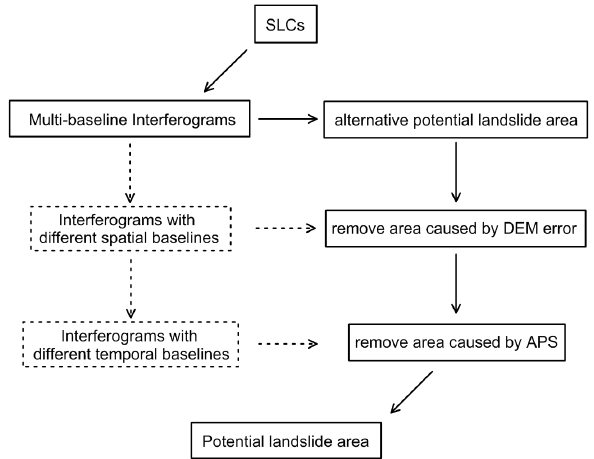
Figure 1. Flowchart of the qualitatively multi-baseline DInSAR method for potential landslide area early detection